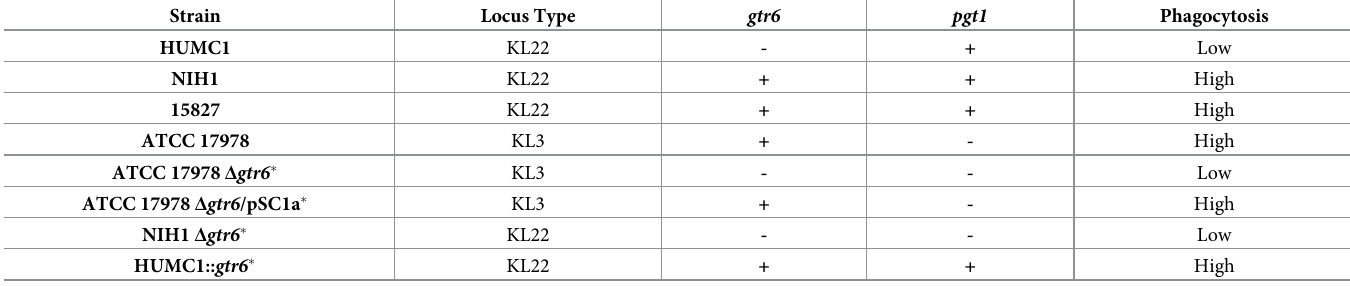
Table 1. Strains by Locus Classification, Genotype, and Phagocytosis Phenotype. All strains used in this study are described according to Kenyon classification capsule assembly locus type, genotype by gtr6 and pgt1 , and relative phagocytic potential.:: = chromosomal gene insertion, / = plasmid insertion, � = generated mutant.